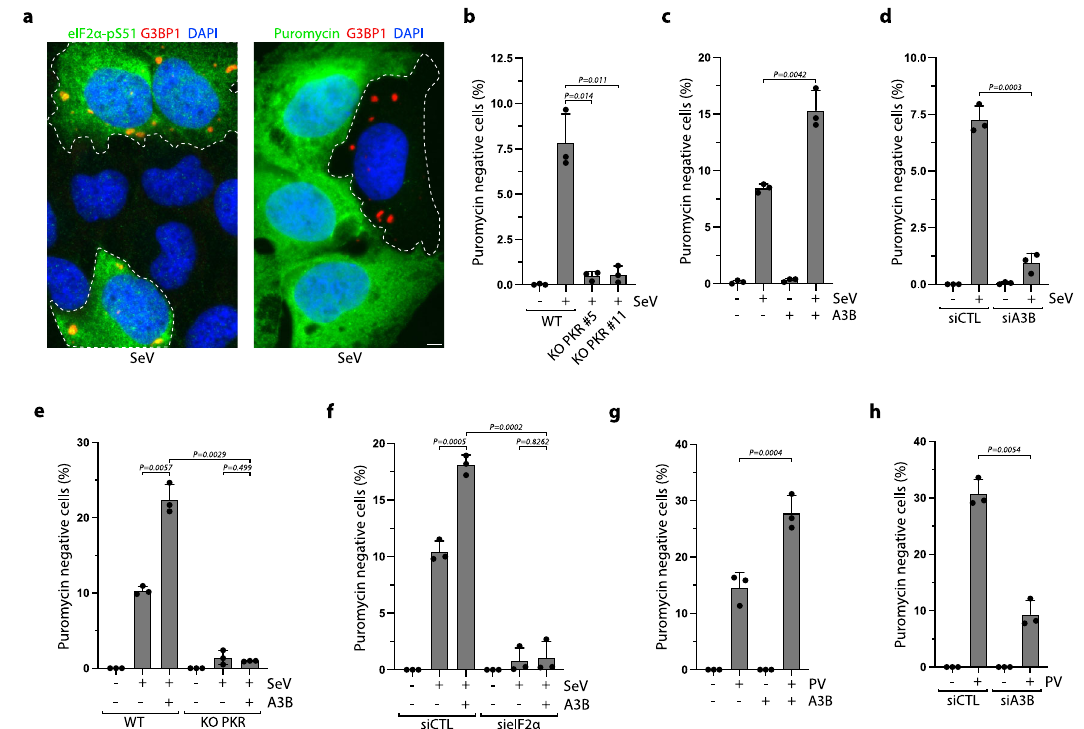
Fig. 4 | A3B enhances PKR-mediated translation arrest. a Representative immuno fl uorescence for G3BP1 and eIF2a-pS51 (left) or puromycin (right) in U2OS cells infected with SeV (MOI=1, 24hpi). SG positive cells are marked with a dotted outline. Scale bar: 5 μ m b Quanti fi cation of puromycin negative cells (%) in U2OS- A3B-FlagandU2OS-A3B-FlagPKRKOcellsinfectedwithSeV(MOI=1,24hpi).Mean values±SD(Numberofbiologicalreplicates, n =3). P -values werecalculatedwitha two-tailed Welch t -test. c Quanti fi cation of puromycin negative cells (%) in U2OS- A3B- fl ag cells ± DOX infected with SeV at 24hpi. Mean values±SD (Number of biological replicates, n =3). P -values were calculated with a two-tailedWelch t -test. d U2OS cells were transfected with siRNA against A3B for 40h and subsequently infected with SeV at MOI=1. At 24hpi, the levels of puromycin negative cells (%) were quanti fi ed by immuno fl uorescence. Mean values±SD (Number of biological replicates, n =3). P -values were calculated with a two-tailed Welch t -test. e U2OS- A3B-FlagWTorPKRKOcells±DOXwereinfectedwithSeVatMOI=1.At24hpi,the